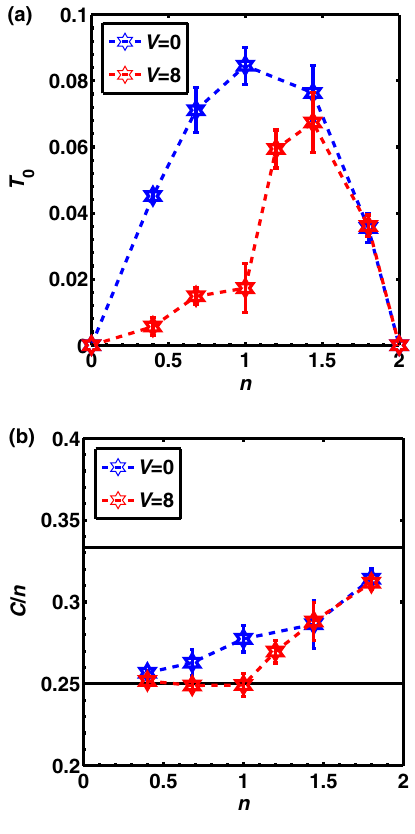
FIG. 3. (a) The density dependence of the Curie temperature T 0 ð n Þ at V ¼ 0 and 8 with J ¼ 2 , respectively. (b) The density dependence of the reduced Curie constant: C=n versus n . The lower and upper bold lines represent the limits of the spin- 1 spin-1 moments, respectively. Plots are based on the results of χ ð T Þ in Figs. 1(a) and